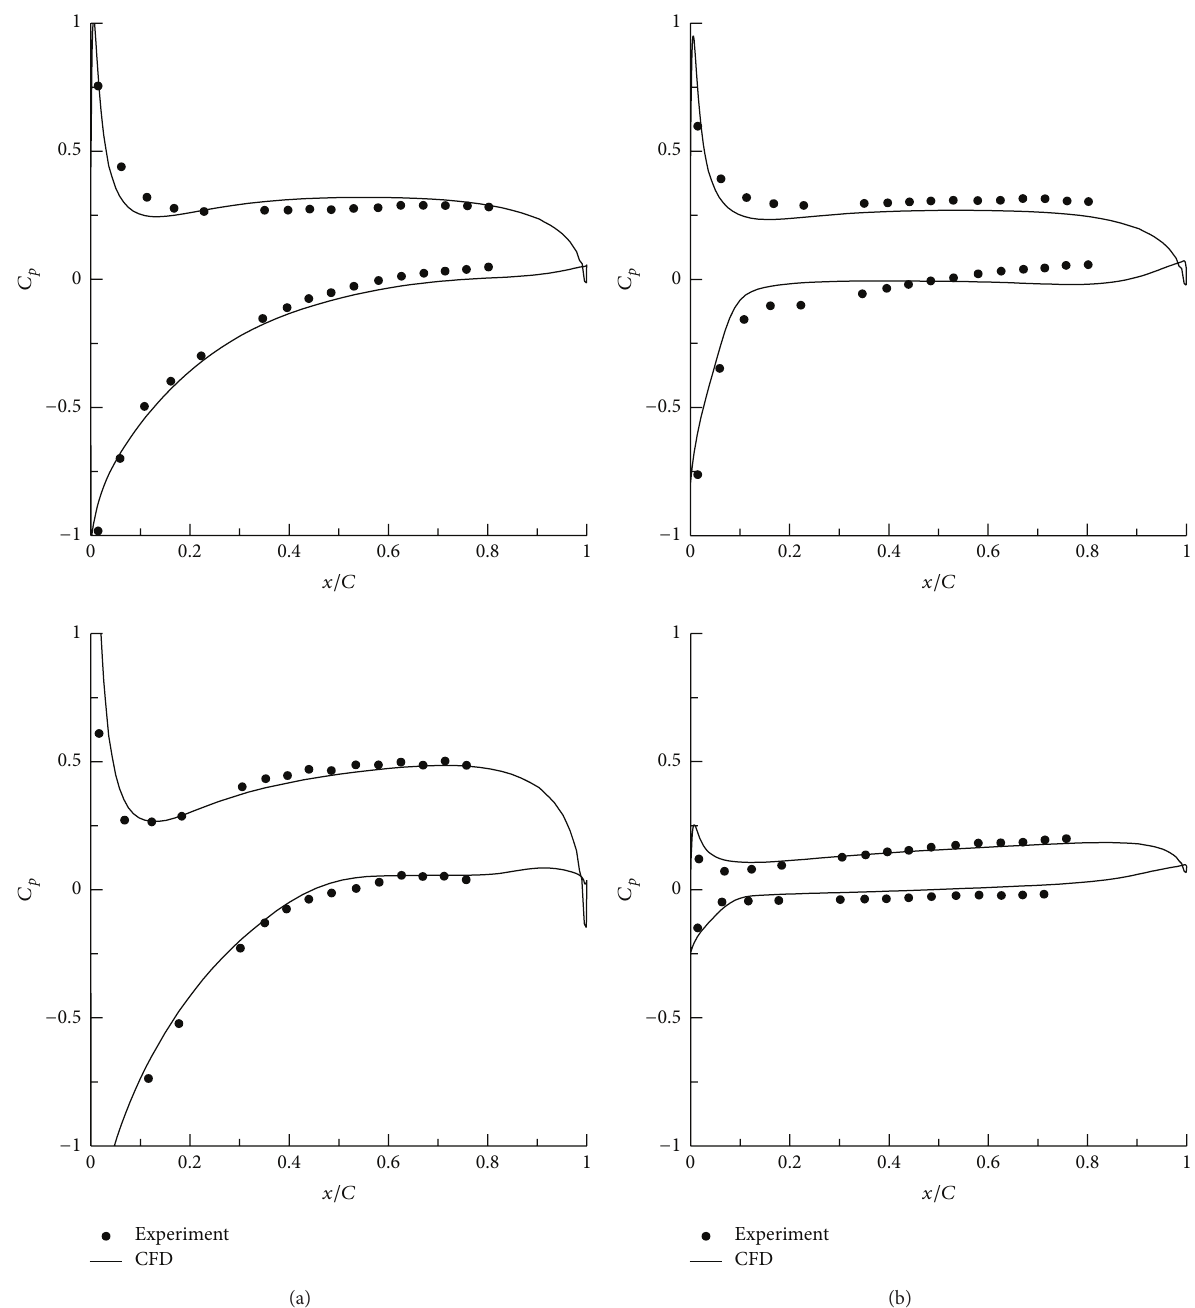
Figure 4: Comparison of 𝐶 𝑝 on C4 blade surface between experiment, and CFD at 𝑖 = 10 ∘ , (a) 𝑧/𝐻 = 50 %, midspan and (b) 𝑧/𝐻 = 0.03 , near the end